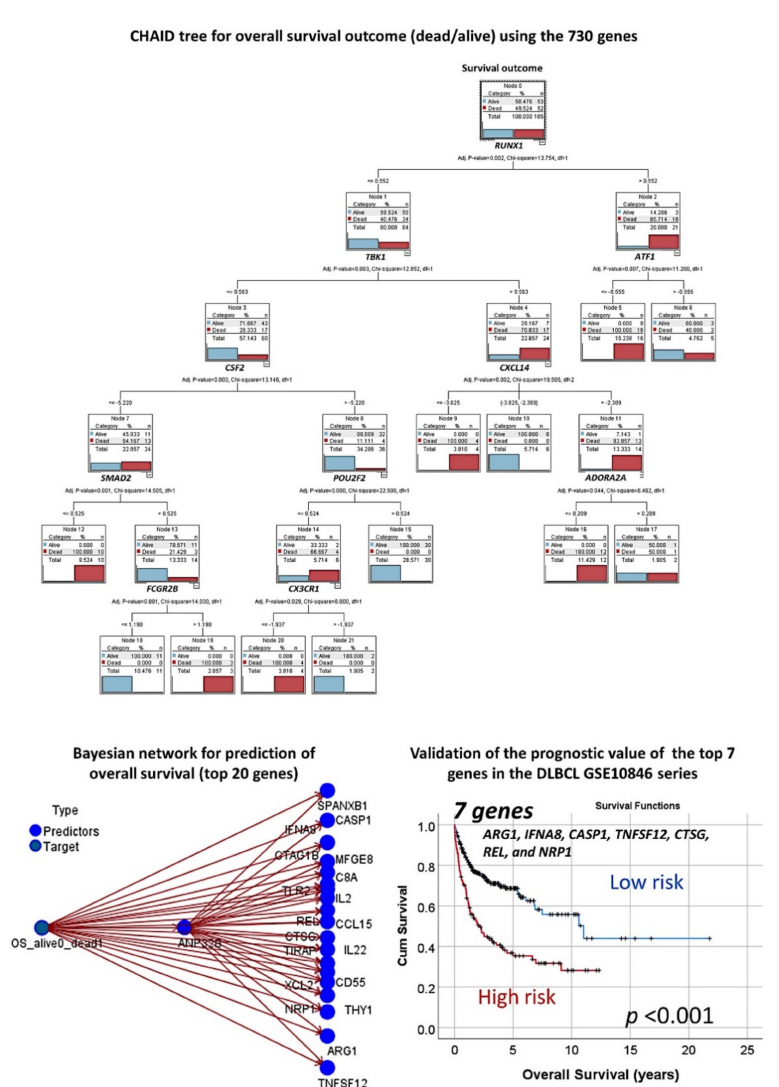
Figure 11. Other machine learning techniques for predicting overall survival. In addition to the artificial neural networks, other machine learning techniques were used. This figure shows the results of the CHAID decision tree and the Bayesian network. CHAID, or chi-squared automatic interaction detection, is a classification method for building decision trees by using chi-squared statistics to identify optimal splits. A Bayesian network is a graphical model that displays variables (nodes) in a dataset and the probabilistic, or conditional, independencies between them. Causal relationships between nodes may be represented but the links (arcs) do not necessarily represent direct cause and effect. Finally, the predictive value of the final set of 7 genes was tested in an independent series of DLBCL of 414 cases, and the results were